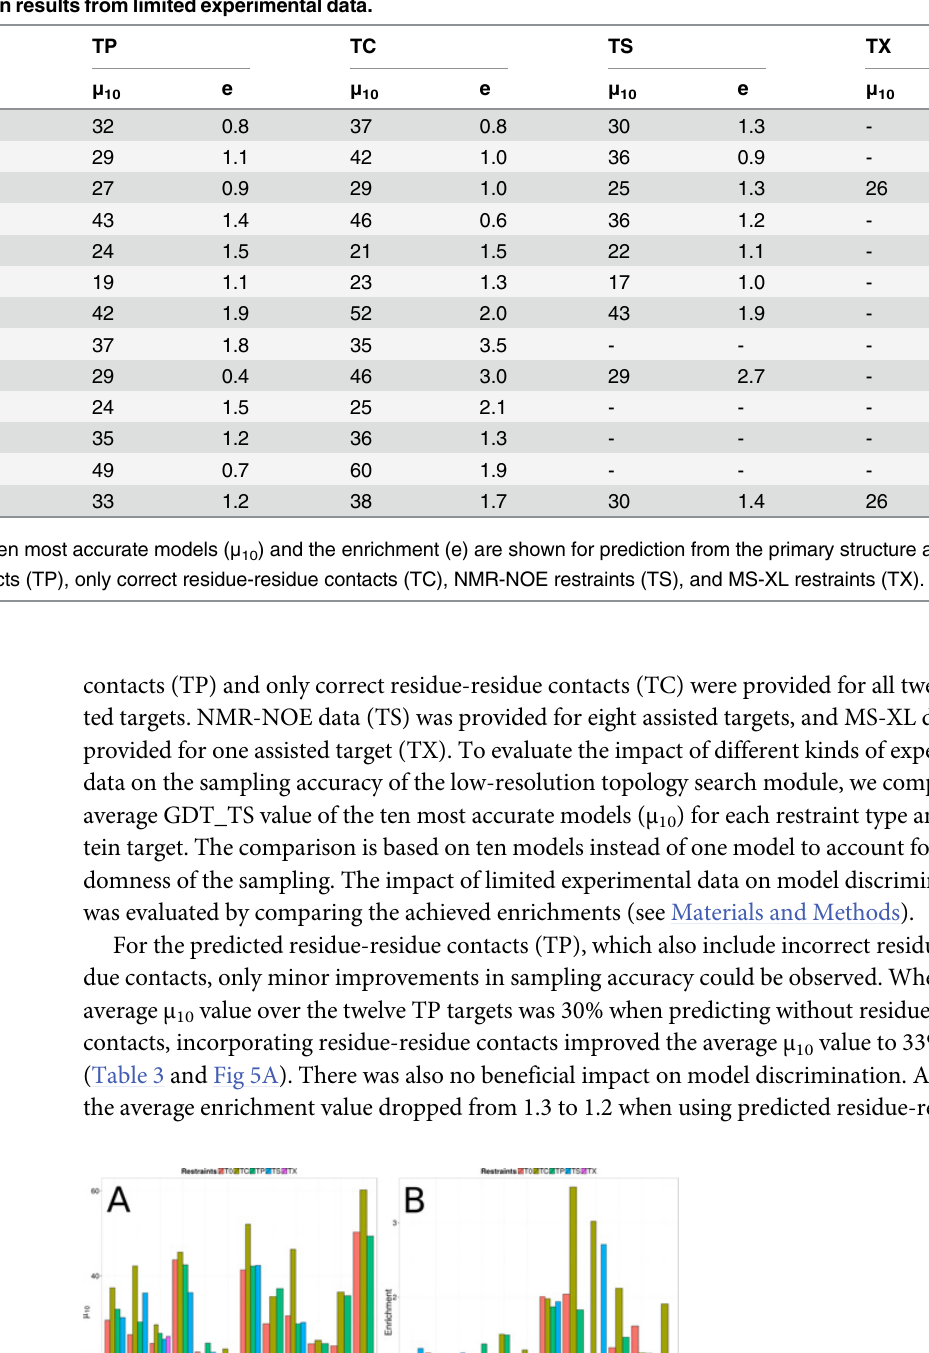
Table 3. Protein structure prediction results from limited experimental data.